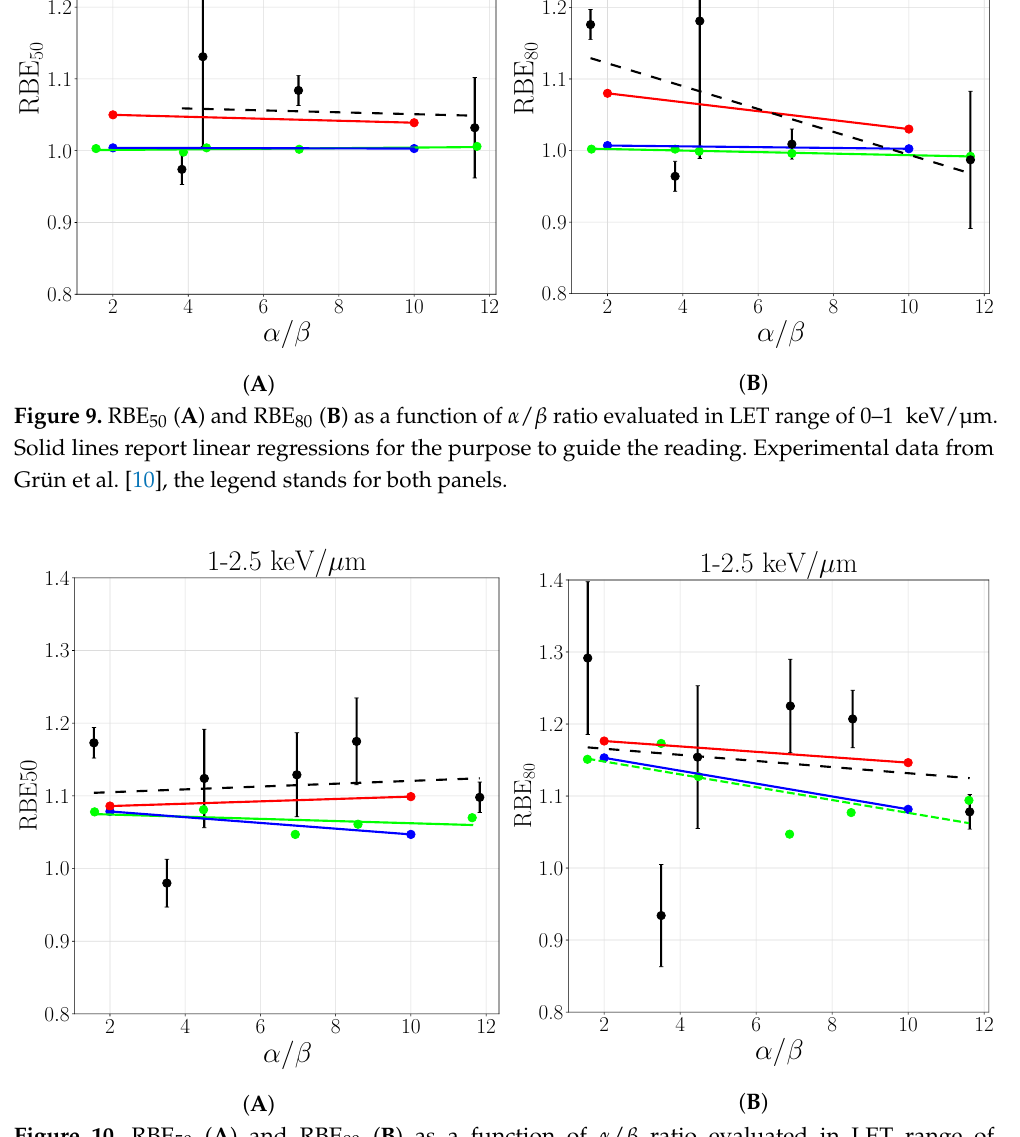
Figure 10. RBE 50 ( A ) and RBE 80 ( B ) as a function of α / β ratio evaluated in LET range of 1–2.5 keV/µm. Solid lines report linear regressions for the purpose to guide the reading. Experimen- tal data from Grün et al. [10], the legend stands for both